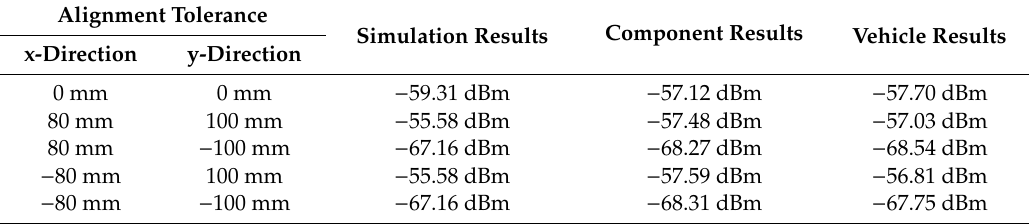
Table 4. Comparison of experimental and simulated results in the − y-direction of the ferrite antenna receiver of the primary device.